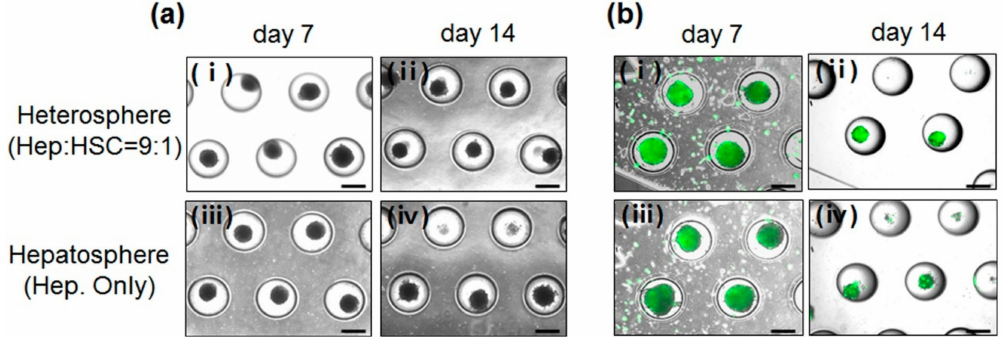
Figure 2. ( a ) Light microscopic images of spheroids formed in concave microwells. ( b ) Viability of cells in the hepatospheres cultured for ( i ) 7 and ( ii ) 14 days; heterospheres cultured for ( iii ) 7 and ( iv ) 14 days in the concave flow chip. Scale bar = 500 µ